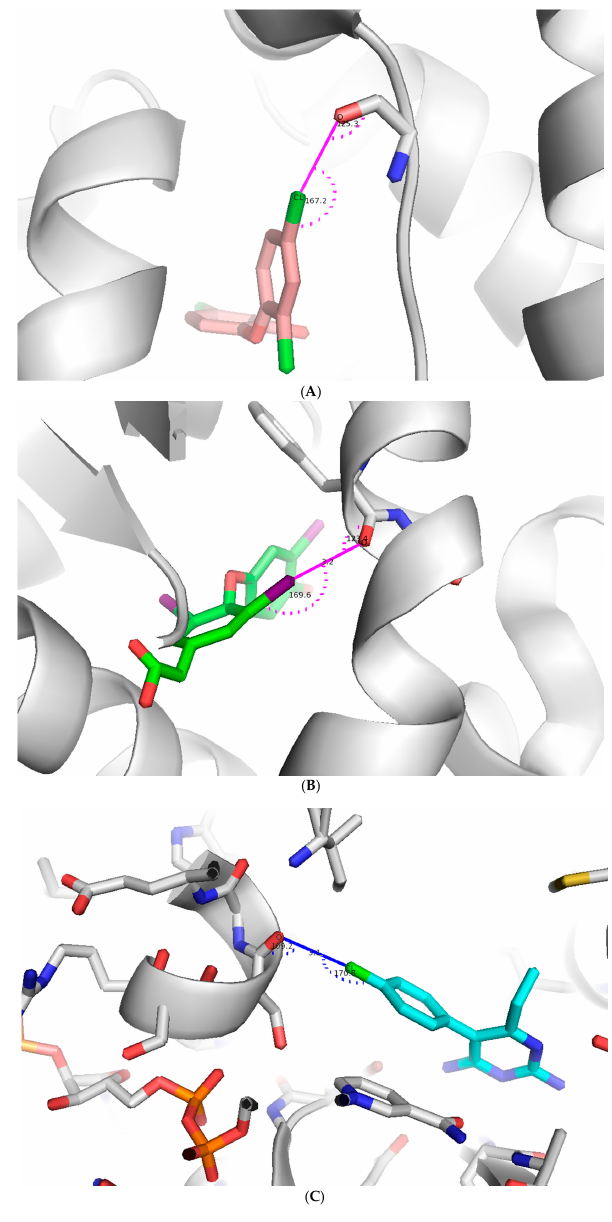
Figure 3. Illustration of a halogen bond in a protein-ligand complex. ( A ) Chlorine forms a halogen bond with main chain oxygen of the protein. The ligand is shown as light pink stick model and protein is shown as both a cartoon model and interacting amino acid as stick model (pdb id: 4ALI); ( B ) Iodine forms a halogen bond with main chain oxygen of the protein. The ligand is shown as an green stick model and protein is shown as both a cartoon and stick model (pdb id: 3JZB); ( C ) Chlorine forms a halogen bond with main chain oxygen of the protein. The ligand is shown as a cyan stick model and protein is shown as both a cartoon and stick model (pdb id: 2B19). Figures were prepared using